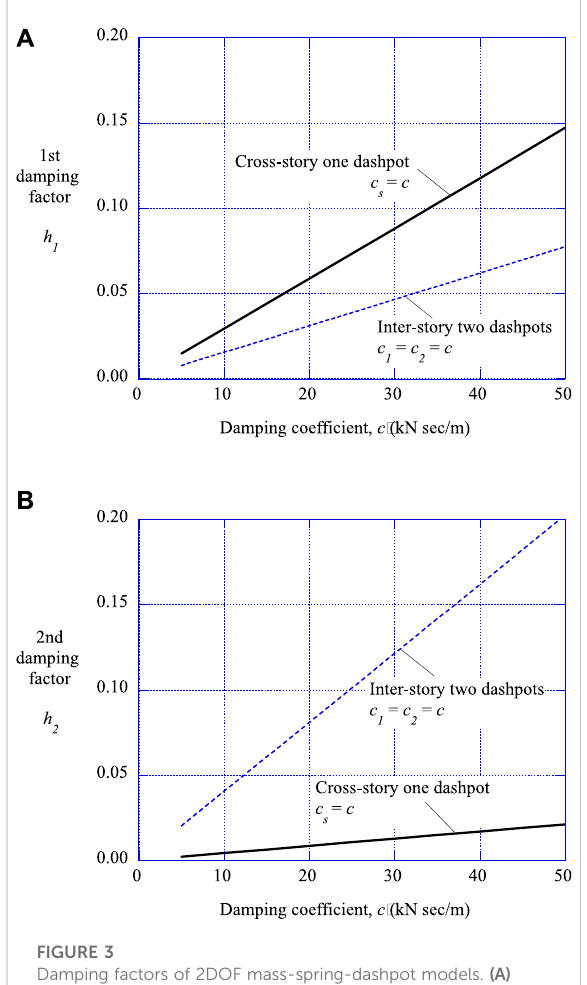
FIGURE 3 Damping factors of 2DOF mass-spring-dashpot models. (A) Relationship between the fi rst damping factor and the damping coef fi cient (B) Relationship between the second damping factor and the damping coef fi